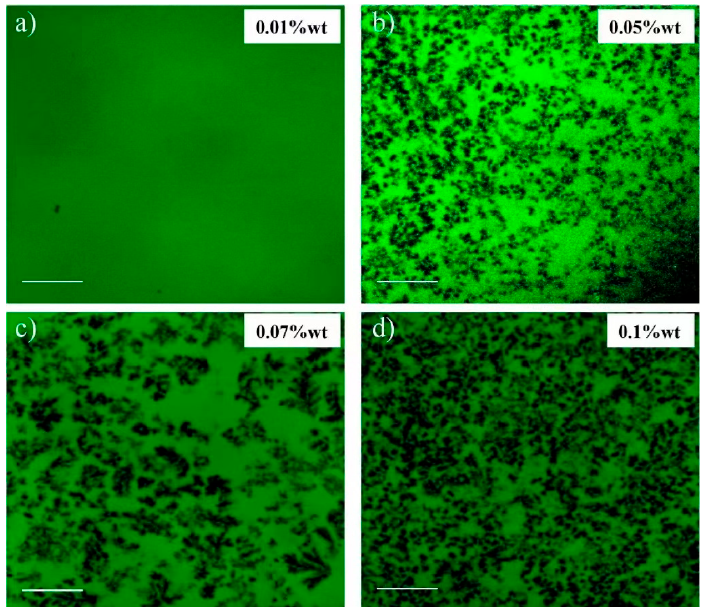
Figure 2. Fluorescence micrographs of Carbopol ® hydrogels at various concentrations of Carbopol ® particles in water phase indicating particle cluster formation and networking with increasing con- centration ( a ) 0.01%, ( b ) 0.05%, ( c ) 0.07% and ( d ) 0.1 wt%) [22]. The scale bar corresponds to 10 μ m. Reproduced from Graziano et al. [22] with permission from Elsevier.